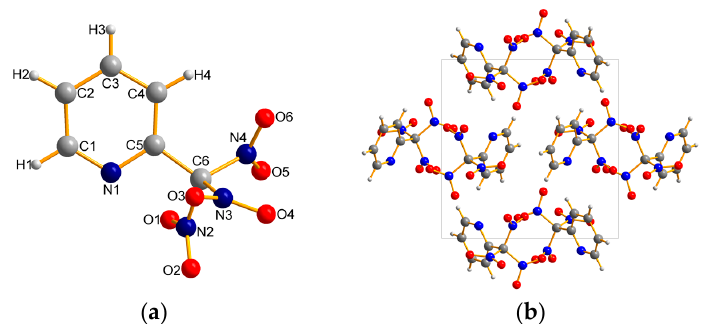
Figure 2. ( a ) Molecular structure of 1 ; ( b ) packing diagram of 1 viewed down the a-axis.